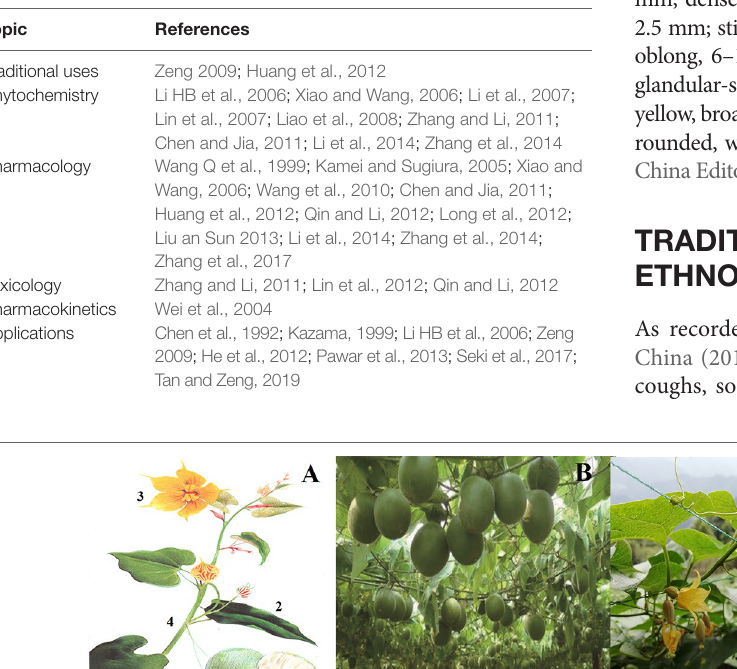
TABLe 1 | Overview of S. grosvenorii related reviews since 1983.